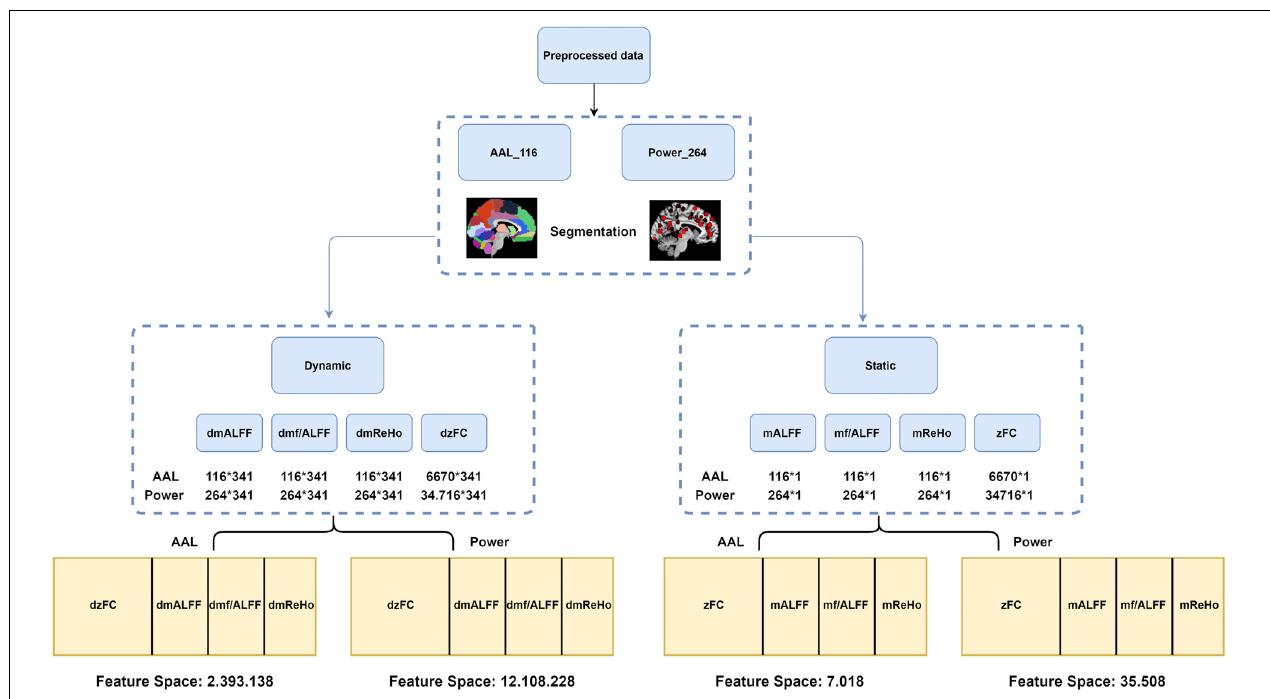
FIGURE 1 | Flowchart of the steps taken in order to extract rsfMRI